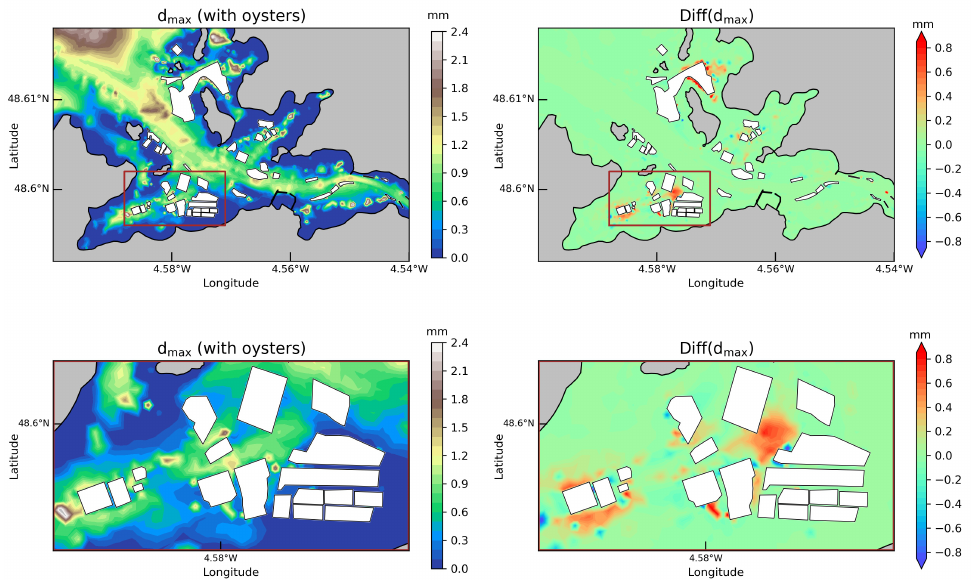
Figure 16. ( top left ) Maximum diameters of bed sediments liable to be moved in mean spring tidal conditions (simulation with oyster tables E 3 ). ( top right ) Differences with respect to the situation without oyster tables (E 3 –E 1 ). The red box in top sub-figures shows the area considered for a detailed view in bottom sub-figures.